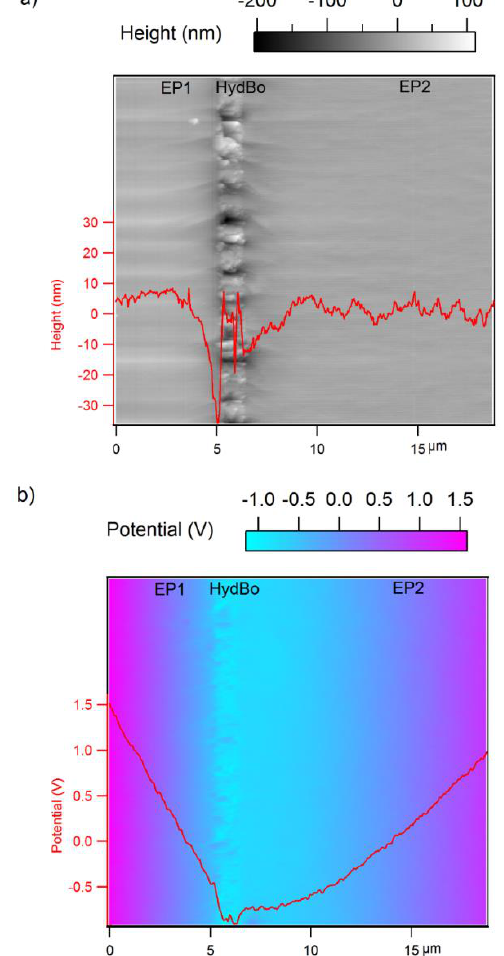
Figure 5. Maps of ( a ) topography and ( b ) surface potential of the cross-section of EP1 / HydBo / EP2 model sample. The line profiles are presented in Figure 5. Maps of a ) topography and b ) surface potential of the cross-section of EP1/HydBo/EP2 model sample. The line profiles are presented in red.